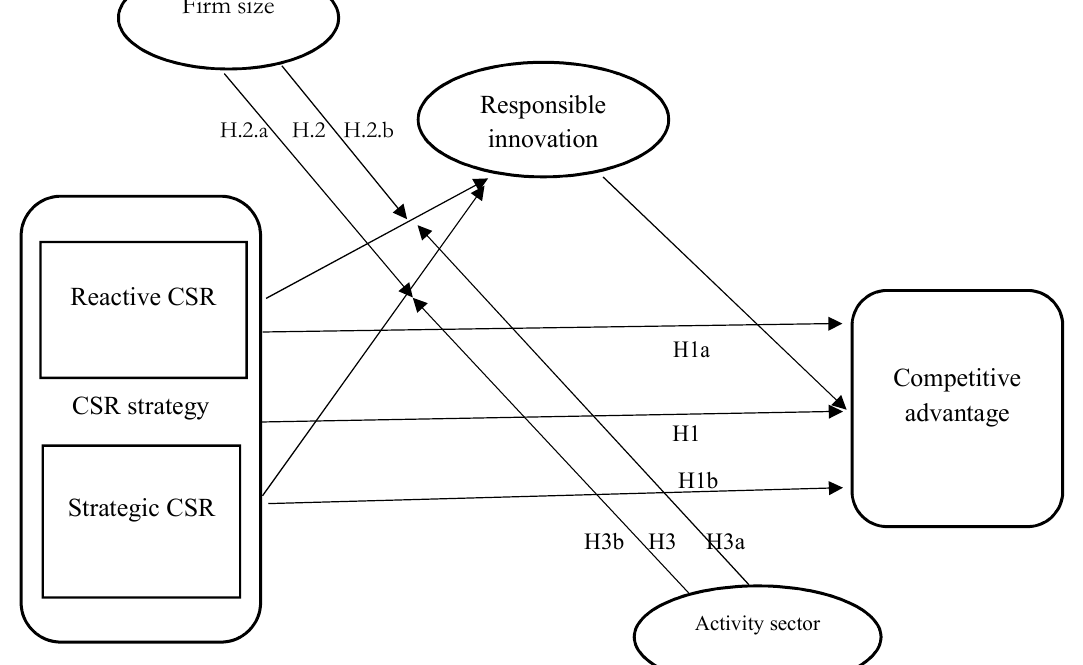
Fig. 1. Conceptual model of the moderated mediation of responsible innovation between CSR strategy and com- petitive